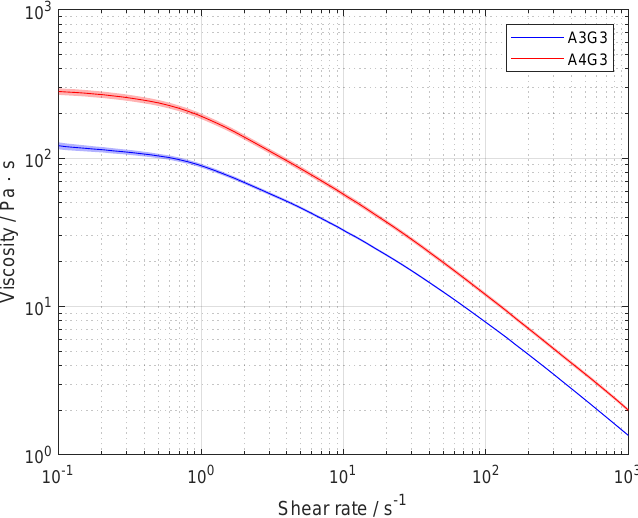
Figure 3. Rheological characterization of biomaterial inks A3G3 and A4G3. Viscosity is shown as a function of the shear rate. The results are presented as mean values, the shaded areas, the standard deviation. Each formulation was prepared separately for three times ( n = 3), and three technical replicates were tested ( n = 3) from each batch, resulting in data sets of nine